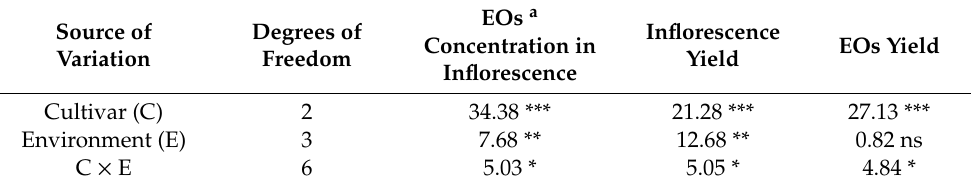
Table 3. Analysis of Variance (F-Value) for Essential Oil (EOs) concentration in inflorescence, inflorescence yield and EOs yield. Source of Degrees